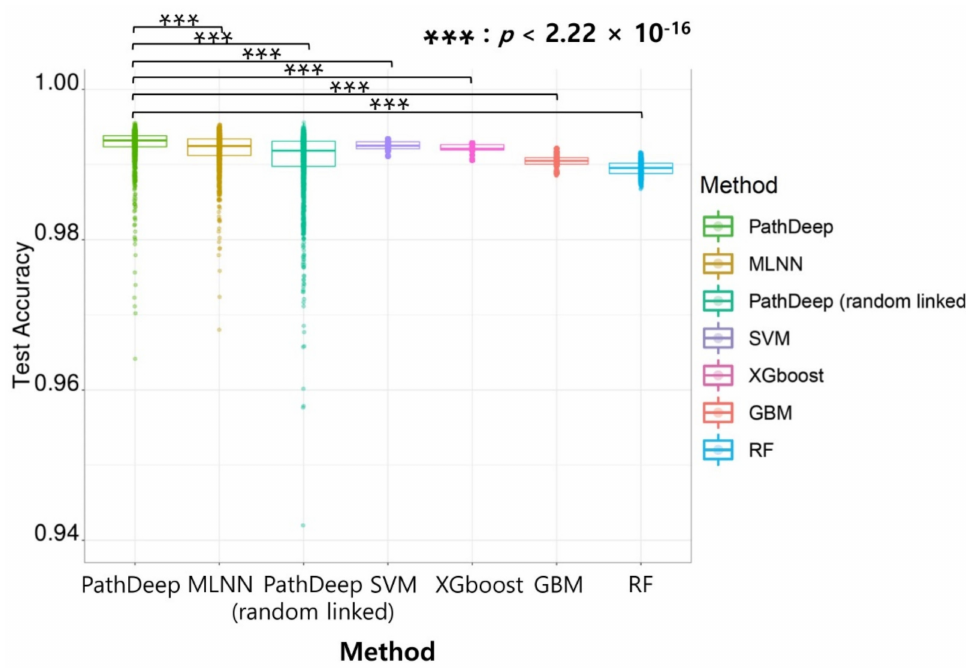
Figure 1. Performance of PathDeep is better than other machine learning